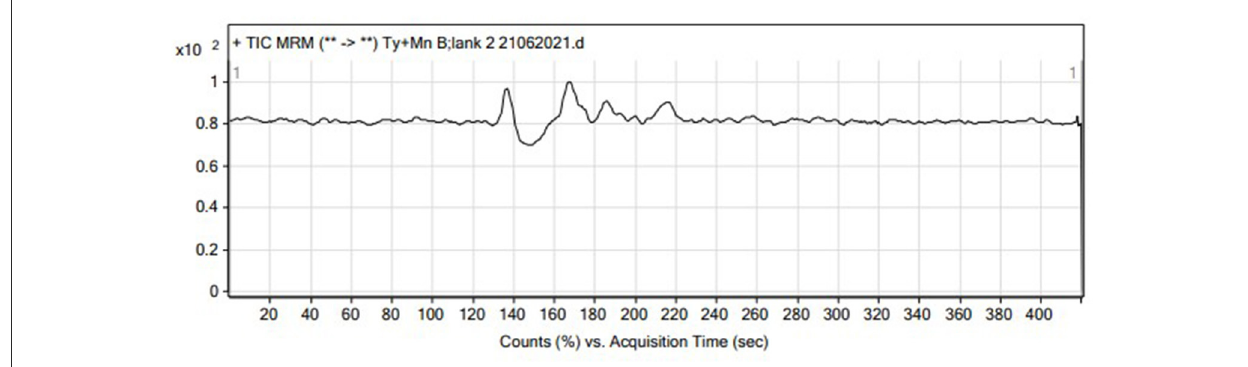
FIGURE3 Multiple reaction monitoring (MRM) chromatogram of Tyl and MNZ matrix blank.